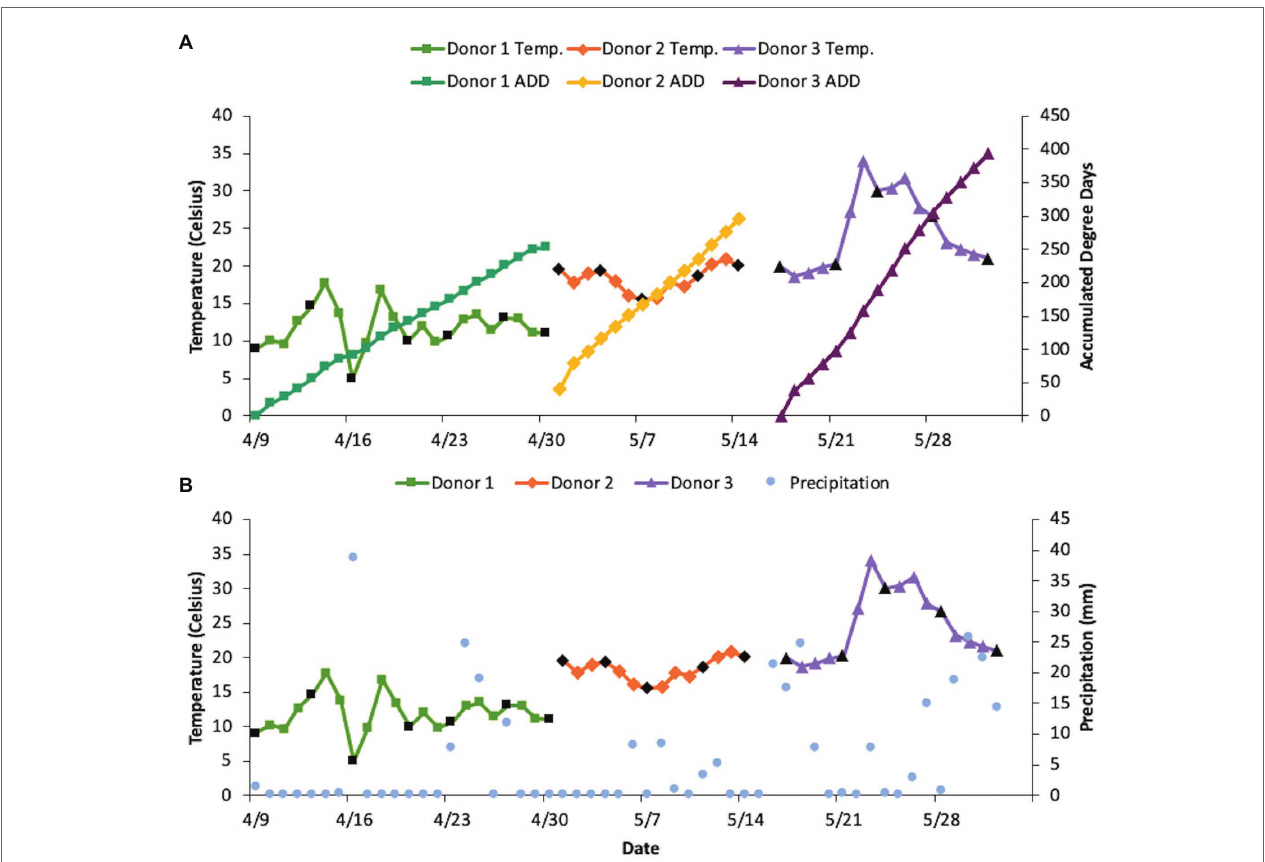
FIGURE 1 | Differences in sampling period, temperature, precipitation (mm), and accumulated degree days (ADD) between donors. Black points denote days on which samples were collected. (Note: The last collection day for each donor was not able to be included because the temperature loggers were collected during sampling, therefore an average daily temperature could not be recorded for those days). (A) ADD compared to the average daily temperatures for each donor. Daily temperatures were significantly different between donors based on one-way ANOVA and Bonferroni post hoc test ( p < 0.01 between all pairs of